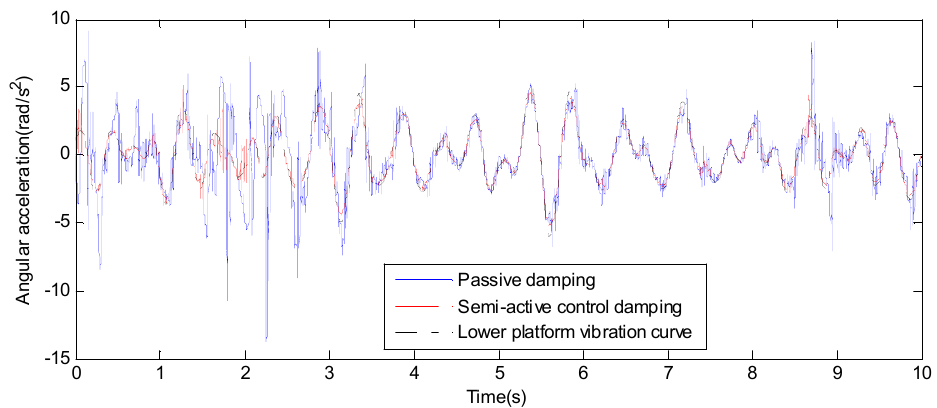
Figure 27. The y -axis direction simulation results.